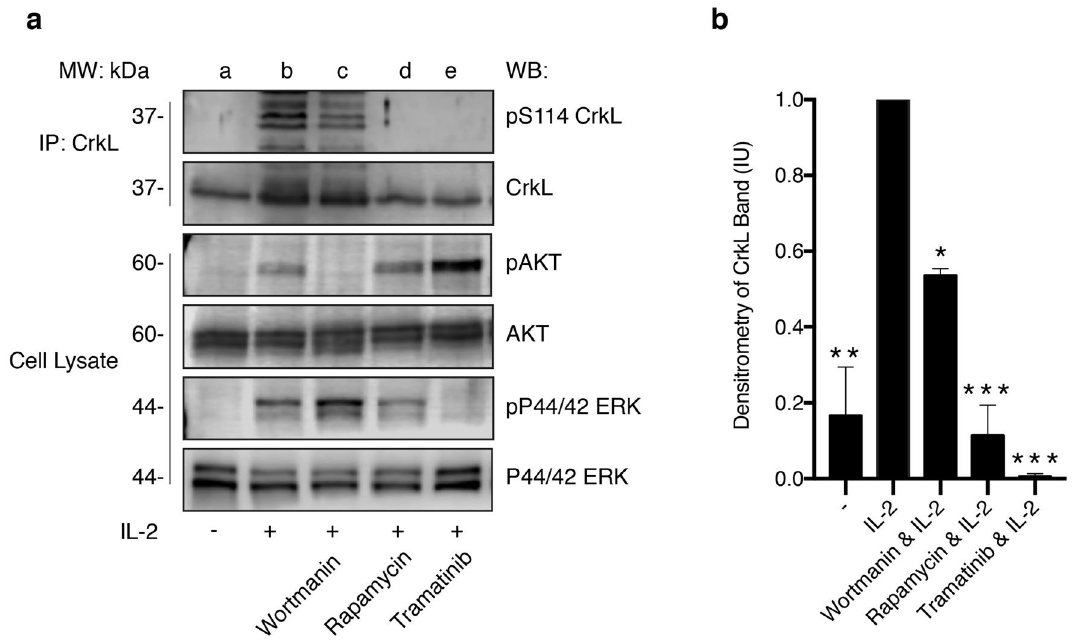
Figure 6. CrkL S114 phosphorylation is dependent on IL-2-induced activation of mTOR and MEK/ERK pathways. ( a ) Quiescent Kit225 cells were either untreated (lane a ), stimulated with IL-2 only (lane b ), or pre- treated with 50 μM wortmannin (lane c ), 100 nM rapamycin (lane d ), and 100 nM tramatinib (lane e ) for 1 h prior to IL-2 stimulation for 30 min. Cell lysate was immunoprecipitated for CrkL protein, Western blotted using α-pS114 and re-blotted for total CrkL. Total cell lysate reserved was Western blotted using α-pERK and α-pAKT, and then reblotted for α-ERK and α-AKT. Full-length blots are displayed in Supplementary Fig. S6a. ( b ) Densitometry analysis was performed on CrkL pS114 from two independent experiments (n = 2) and the mean Intensity Unit (IU) for each condition represented in the bar graph. (***) denotes P > 0.001, (**) denotes P > 0.01, (*) denotes P >